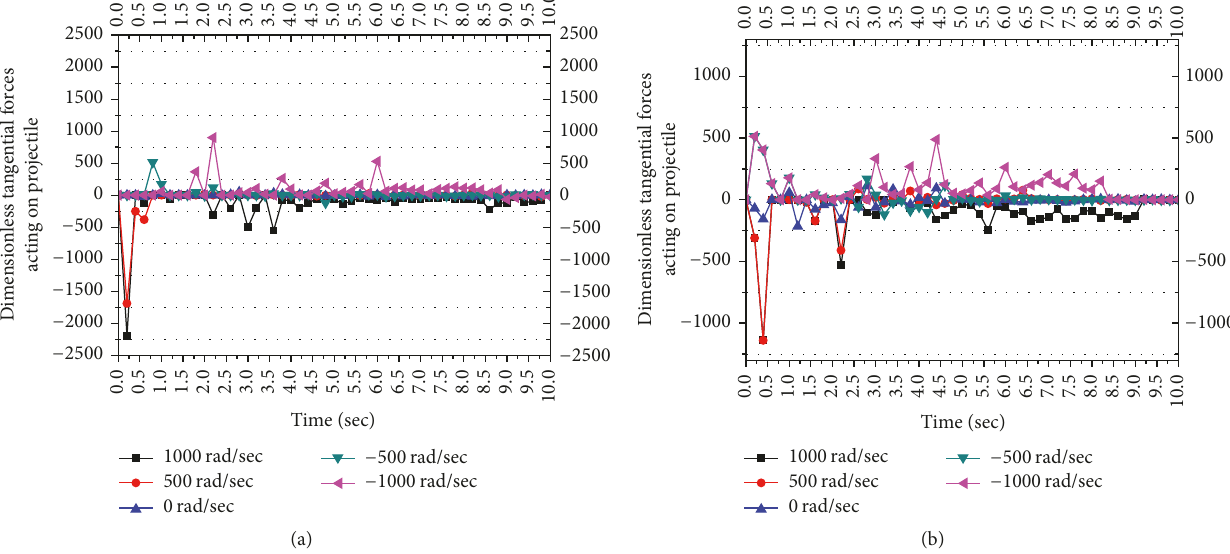
Figure 4: Tangential forces acting on the projectile during penetration process. (a) Multisized particle bed. (b) Monosized particle